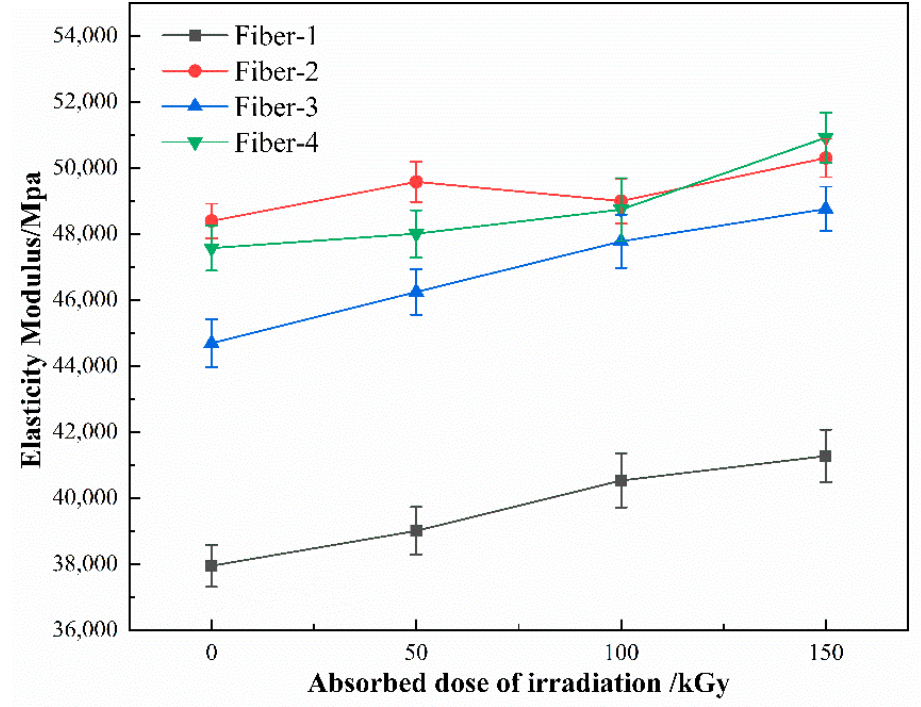
Figure 13. Variation of fiber elastic modulus with the gamma irradiation absorbed dose.